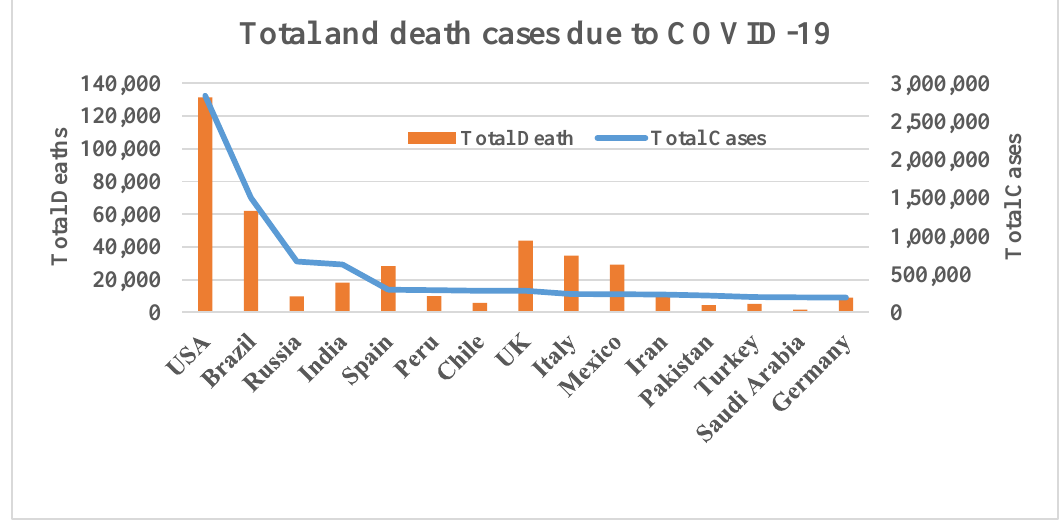
Figure 1. Total and death cases in the top 15 highly affected countries with COVID-19. Source: https://www.worldometers.info/coronavirus/#countries; Assessed on: July 03, 2020.